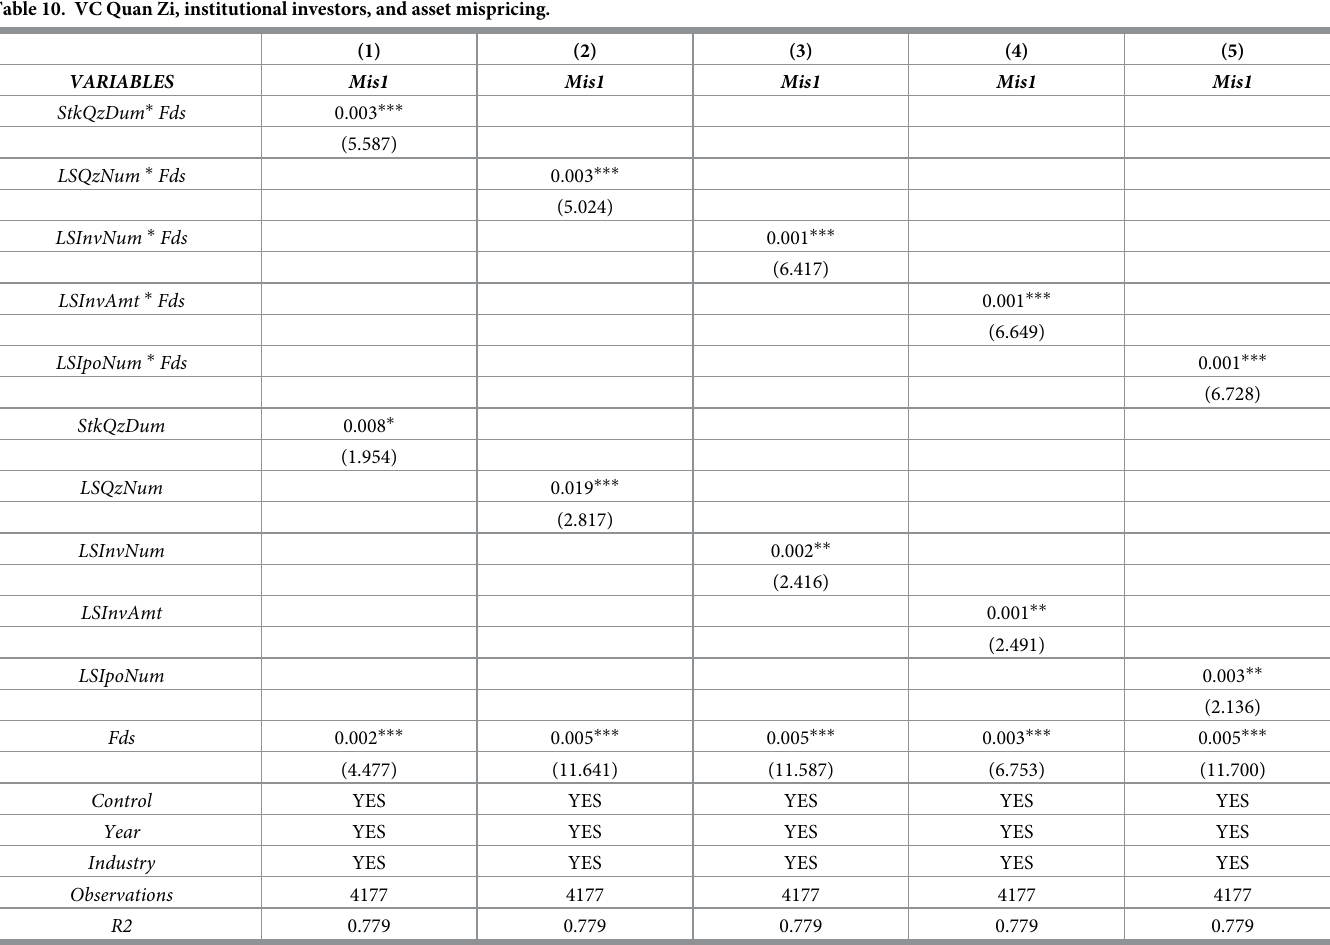
Table 10. VC Quan Zi, institutional investors, and asset